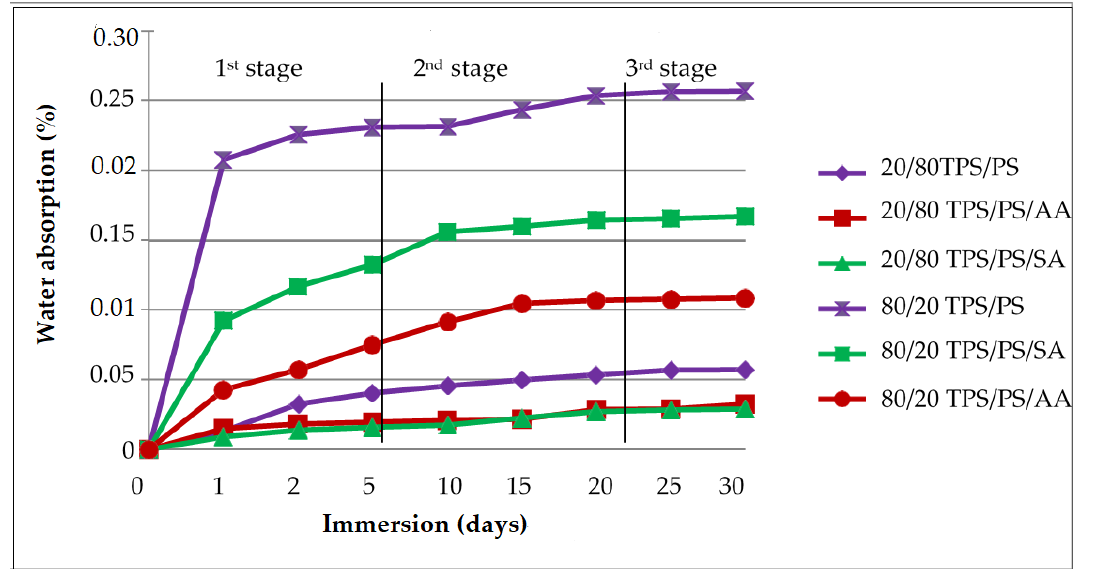
Figure 12. Water absorption of untreated and treated with AA and SA at two different